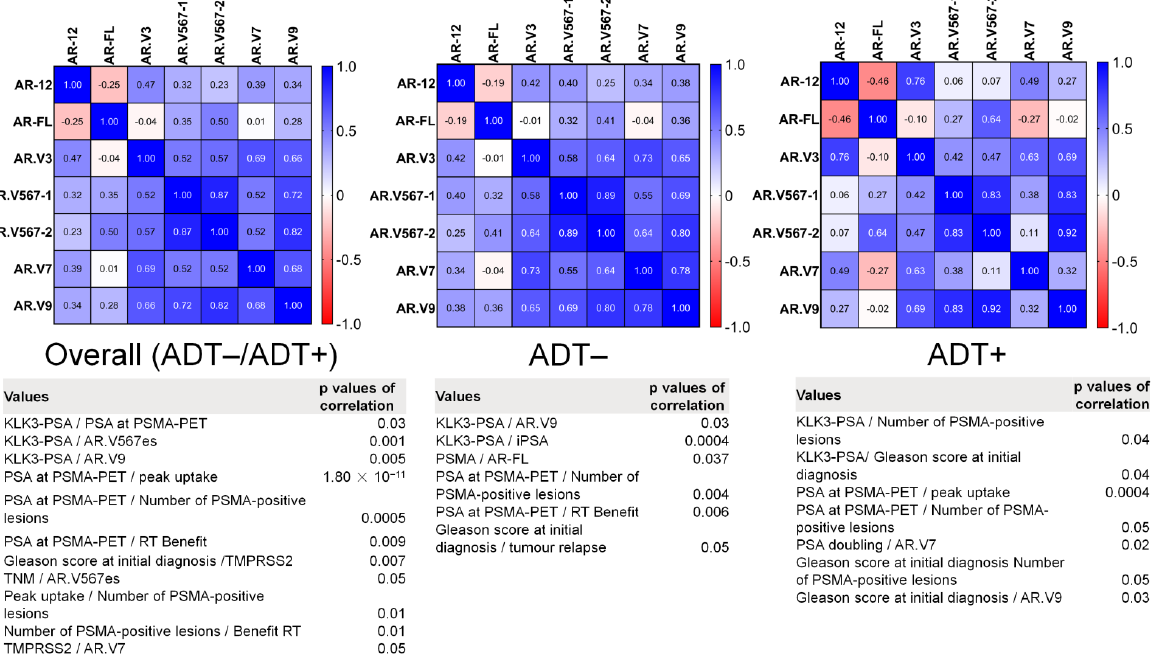
Figure 3. Correlation analysis. Heatmap profiles for the AR variant correlations in overall, ADT− , and ADT+ cohorts (upper panel). The overview of significant correlations for the clinical variables, stratified by ADT application or overall (lower panel). The meaning of the color-coding on the heatmaps is as indicated in the key, with 1 representing the highest positive correlation value and −1 representing highest negative correlation.